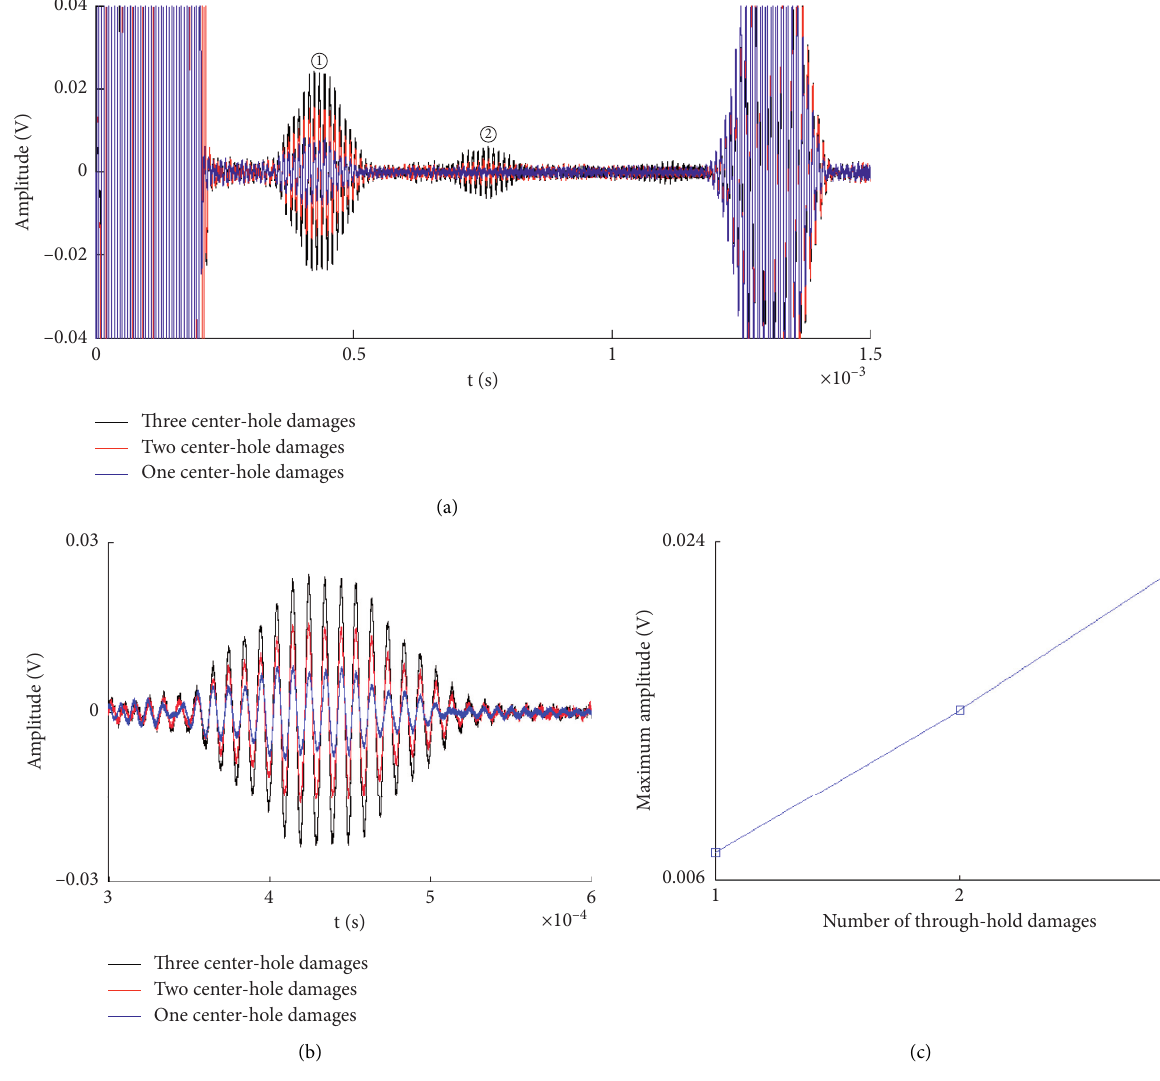
Figure 20: Temporal waveforms received from multiple circular through-hole damages along the circumferential direction: (a) overall time domain waveform; (b) time domain waveforms of the first reflection wave packets of L (0, 2) mode; and (c) maximum amplitude of the first L (0, 2) mode reflection wave packet with the number of the damages.